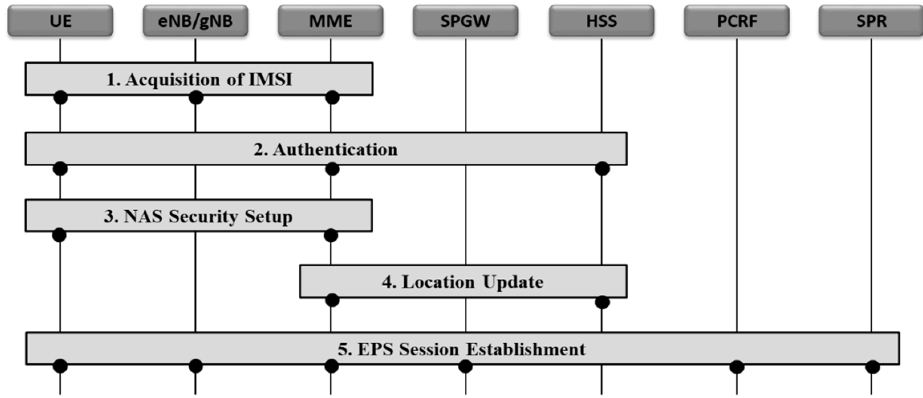
Figure 2. NSA Attachment procedure of 5G NSA.